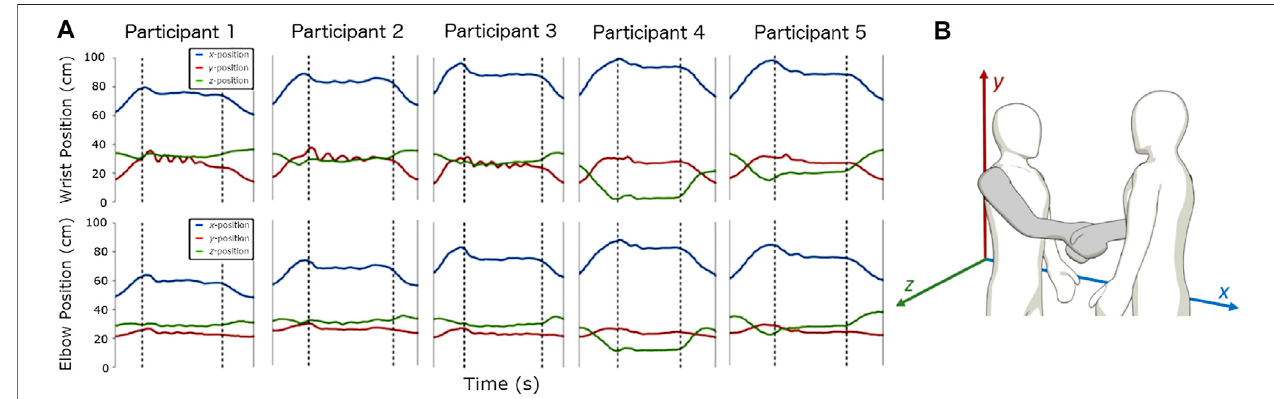
FIGURE2| Positionplots anddescription ofthepositionofthehand. (A) Shownaretheplotsfromthesensorsatthewristand attheelbowoftheparticipants. (B) The location of the transmitter of the tracker, which serves as the reference frame for the tracker data. The x -position (blue) represent the reaching, y -position represent the up and down arm movements, and the z -position represent the panning adjustments to the handshake partner.